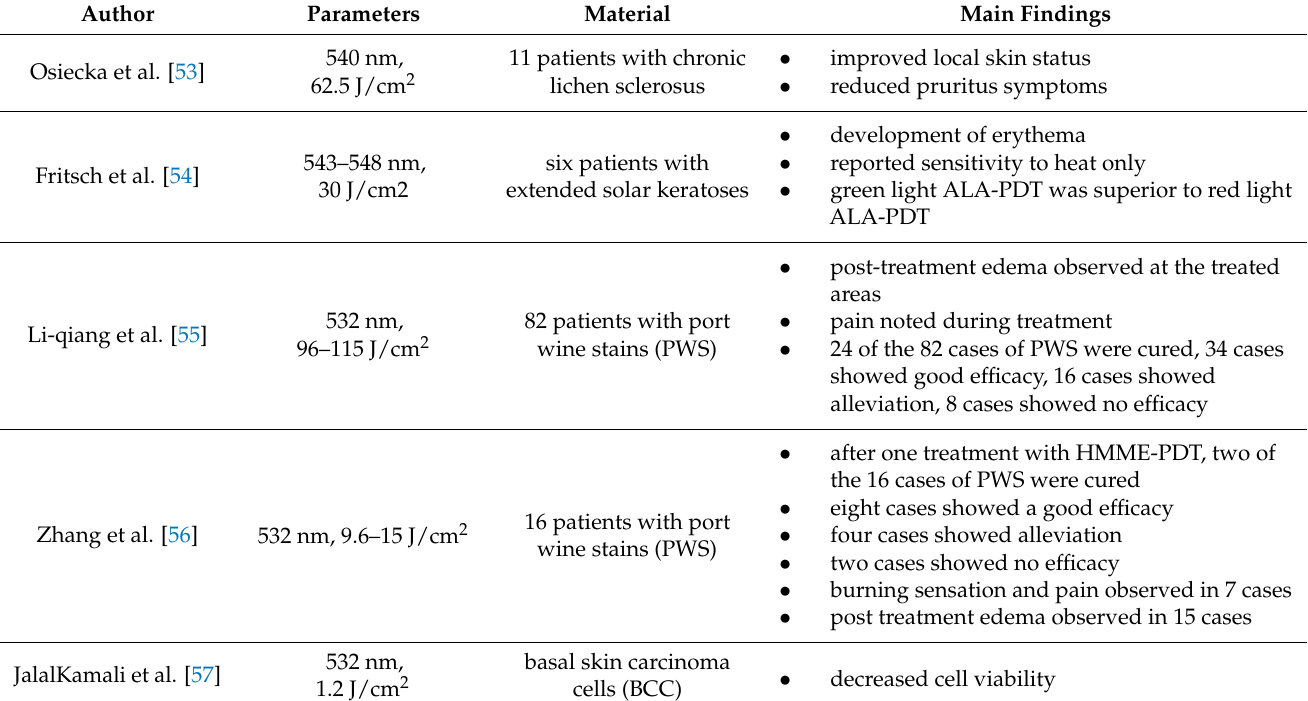
Table 3. Green light (495–570 nm) effect on skin